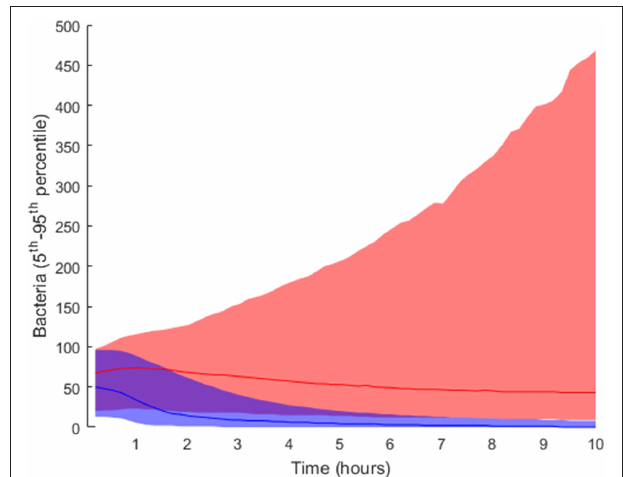
FIGURE 4 | Distribution of final bacteria numbers in the simulations accounting for the influence of tissue level parameters. The figure shows the evolution over time of the interpercentile range between the 5th and 95th percentiles in the two groups: high load group in pink and low load in blue. The solid lines in darker shades represent the median of each